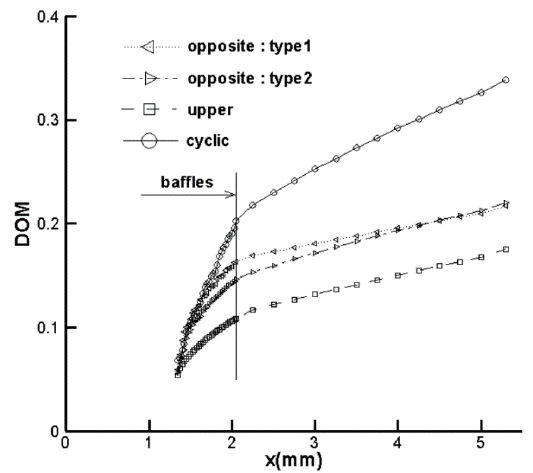
Figure 7. Comparison of the DOM evolutions along the outlet branch.